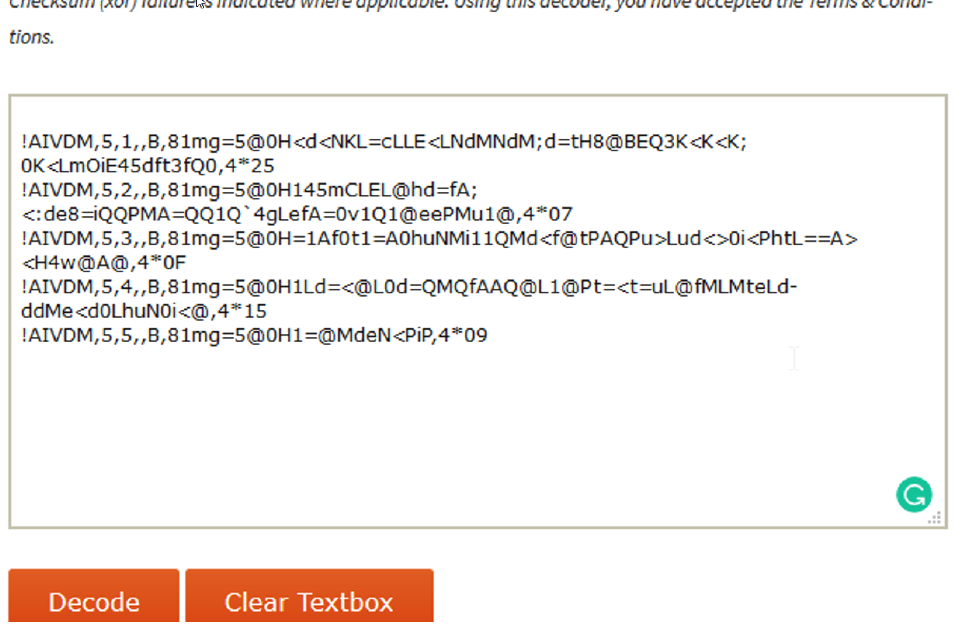
Figure 9. ID8 AIS Message that encapsulates the original signed message, the added timestamp, and the variable cryptographic parameters of the signature.